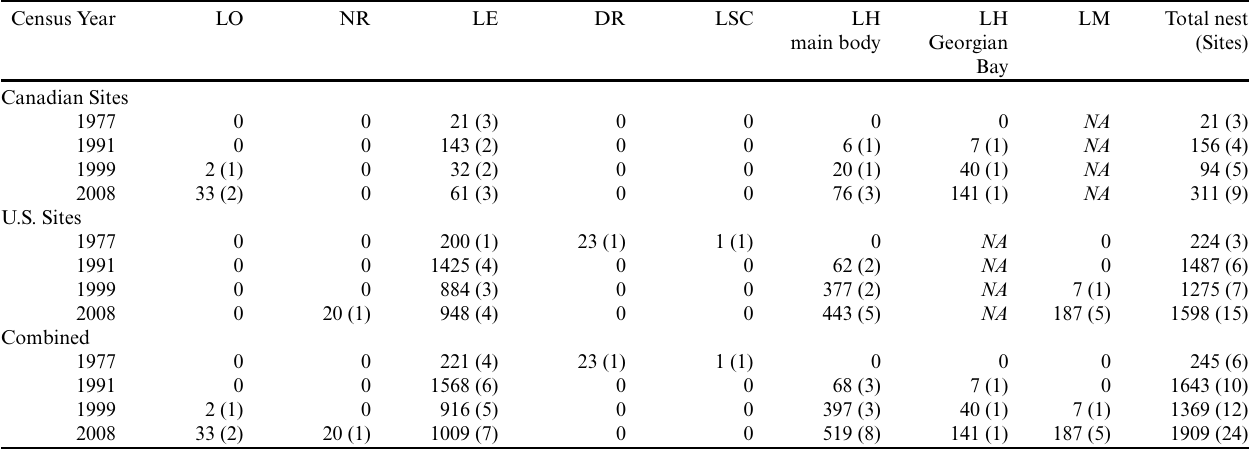
Table 2 . Location, size, and number of active Great Egret ( Ardea alba ) colonies by country and water body during the four decadal census periods. Values reflect total nest count per water body with number of active colony sites shown in parentheses. Water bodies are presented on an east-west gradient. Values of zero indicate no nesting activity reported in water body during the indicated census period. NA denotes “not applicable” because the water body does not occur in both jurisdictions. DR indicates Detroit River; LE, Lake Erie; LH, Lake Huron; LM, Lake Michigan; LO, Lake Ontario; LSC, Lake St. Clair; LS, Lake Superior; NR, Niagara River; SLR, St. Lawrence River; SMR, St. Marys